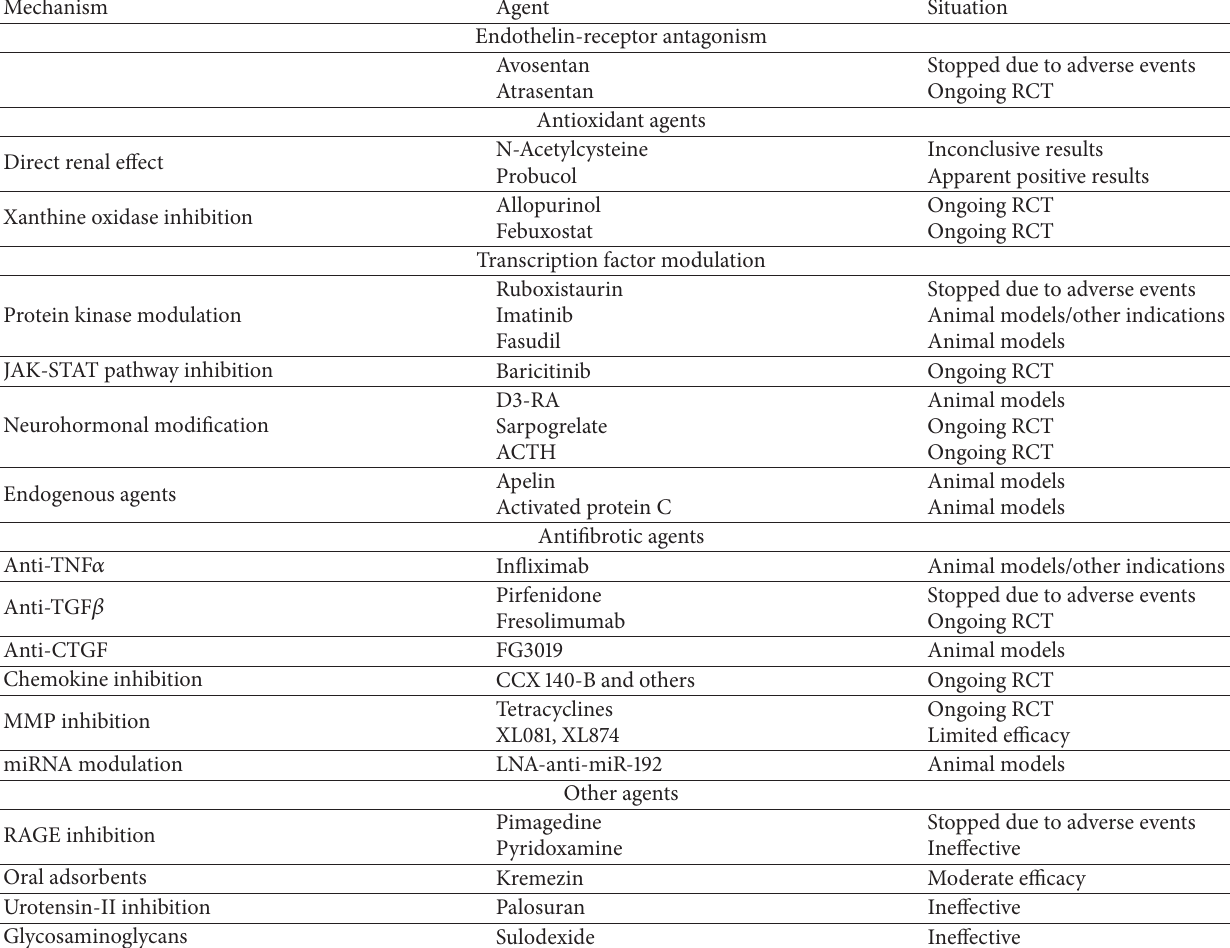
Table 2: Summary of main pathogenic pathways and agents under evaluation for diabetic